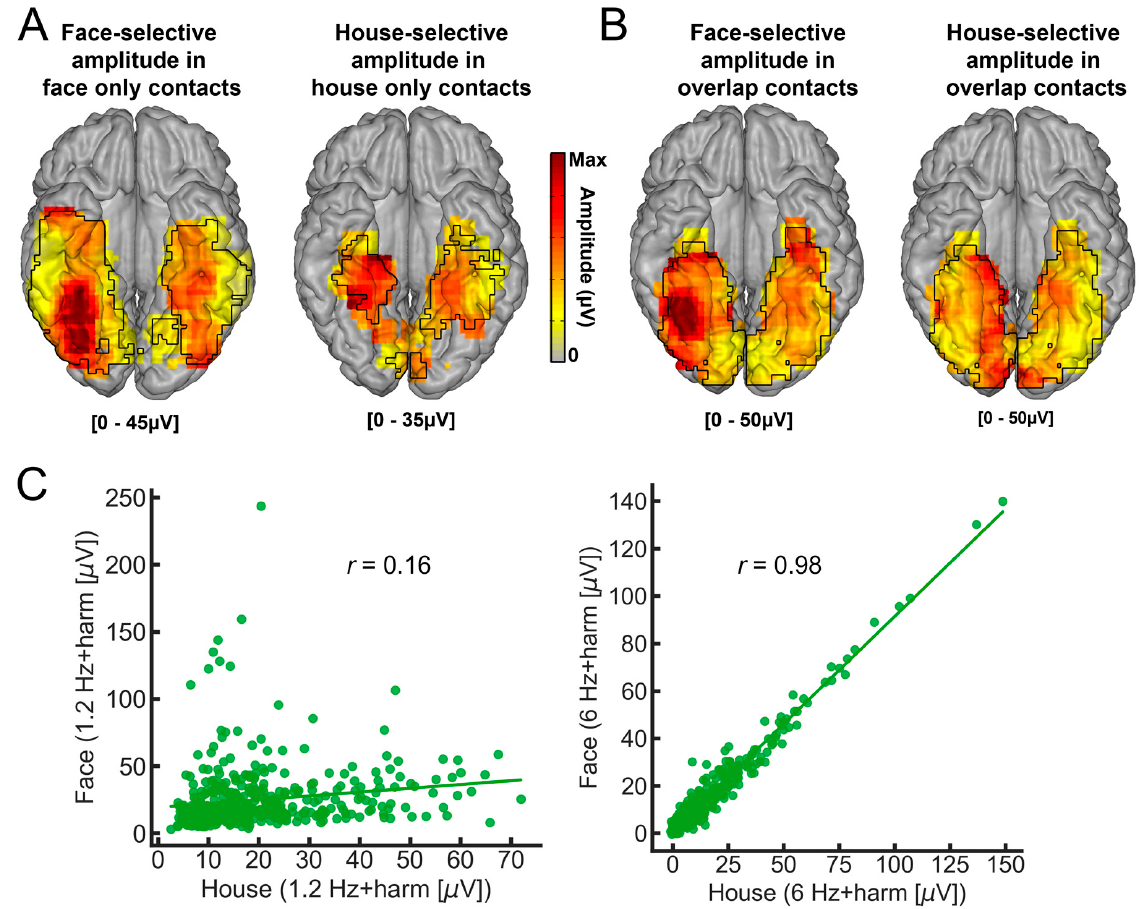
Figure 11. ( A ) Color-coded smoothed spatial maps of the local amplitude measured at selective contacts for only one category, face-selective or house-selective contacts (see examples in Figure 10C, displayed on the ventral cortical surface (from [152]). Note the clear spatial dissociation between the localization of face- and house-selective contacts, with house-selective responses located mainly in medial occipito-temporal regions. ( B ) Spatial maps of the local amplitude -of selective-contacts for both categories (overlap contacts), separately for the face- and house-selective responses. The spatial dissociation is also found at this level, with lateral (faces- and medial (houses) relative distributions of amplitudes. ( C ) For these overlap contacts, despite a ceiling correlation for the base rate response, there was virtually no correlation in amplitude between the response recorded for faces and houses, suggesting that the category-selective responses are generated by different populations of